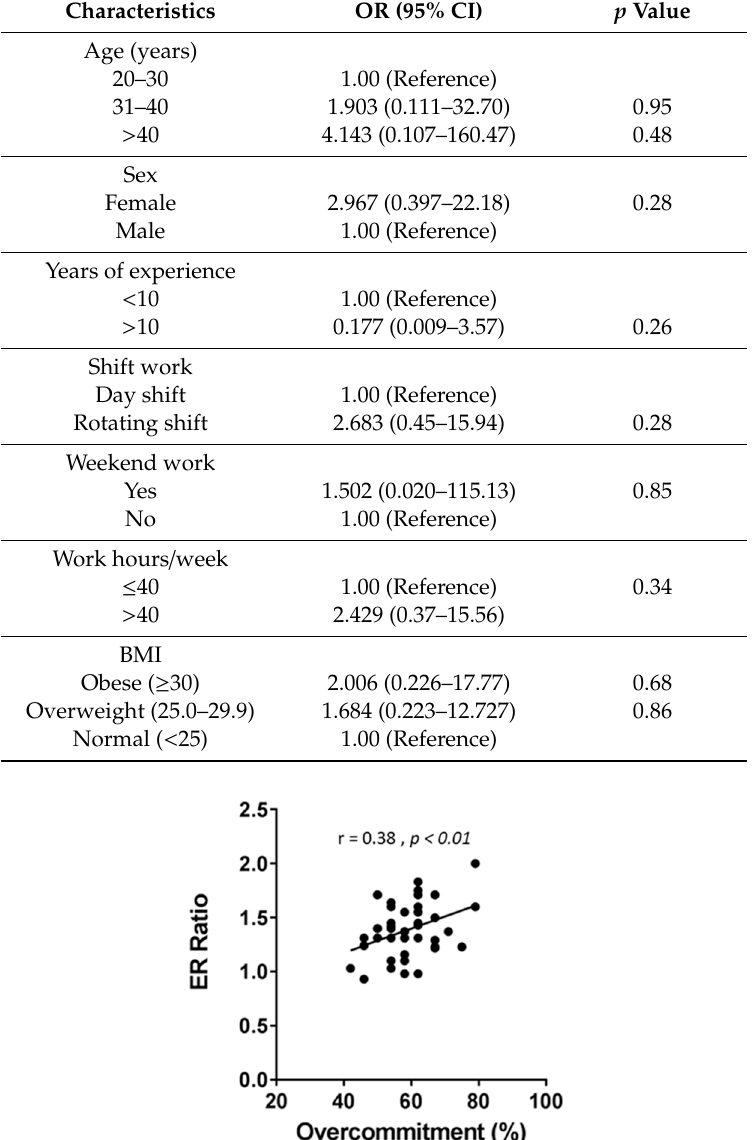
Figure 6. Graphical representation comparing malondialdehyde level in high and low overcommitted nurses. Malondialdehyde (MDA) was measured in the urine samples of the study participants and compared (OC > 50 vs. OC ≤ 50; p < 0.04) using Mann–Whitney test. Figure 7. Graphical representation comparing 8-isoprostane levels in day shift and night shift female nurses. 8-isoprostane (8-IsoP) levels were measured in the urine samples and compared (female day shift nurses vs. female night shift nurses; p < 0.001) using Mann–Whitney non parametric test. A significant difference was observed in 8-IsoP levels between female day shift and night shift nurses ( p < 0.001).